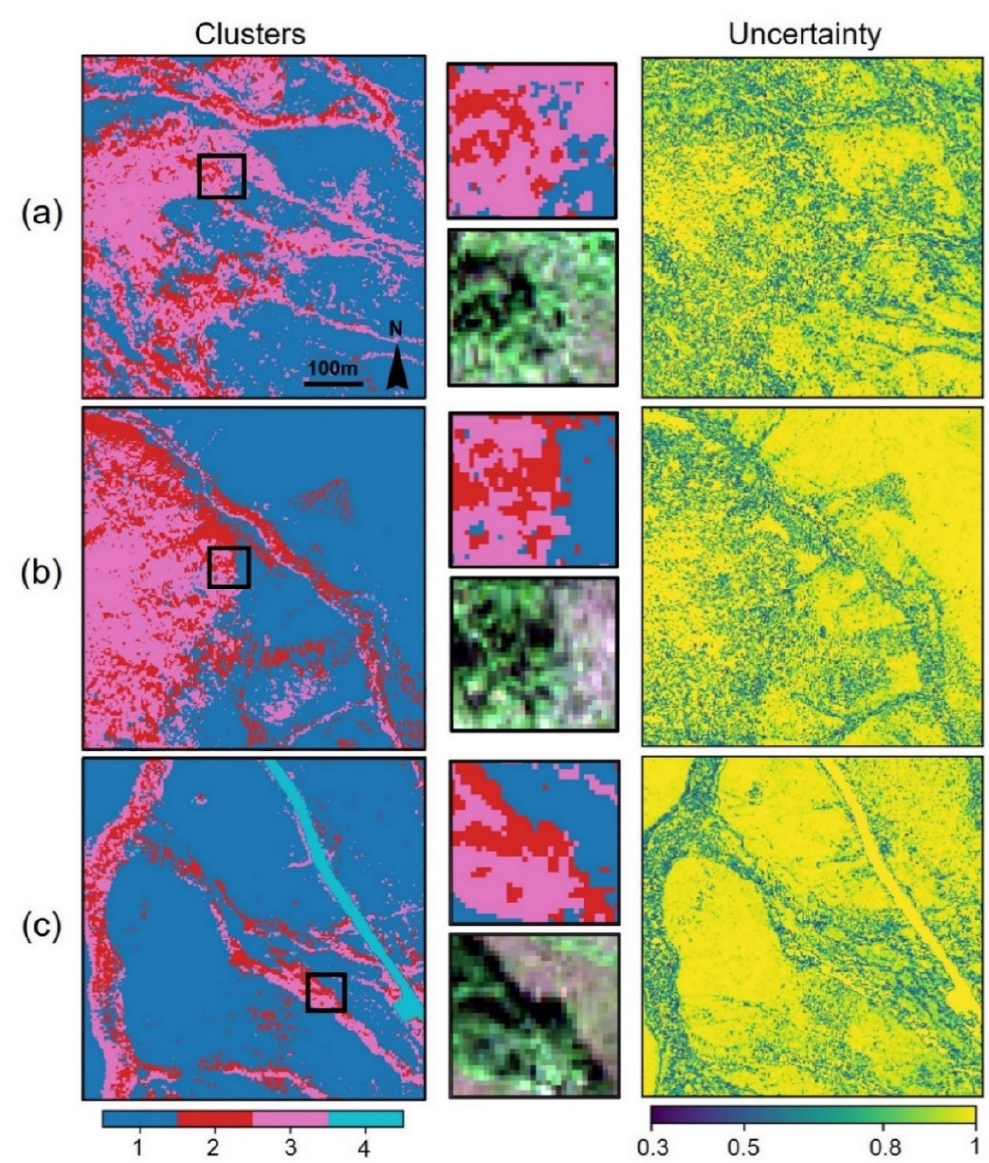
Figure 4. Pixel-wise clustering results and the associated uncertainty maps, ( a – c ) correspond to Site-1, Site-2, and Site-3, respectively. The four clusters 1, 2, 3, 4 were identified as pseudo-ground, darker regions (e.g., shadow, dark green vegetation), green vegetation, and concrete road, respectively. Clustering results at locations outlined by black boxes were magnified for better comparison with satellite RGB images. Uncertainty maps display the cluster membership probabilities. Higher cluster membership probabilities imply purer clustering results with lower confidences being other clusters, whereas lower probabilities suggest more ambiguities in discriminating one cluster from others.